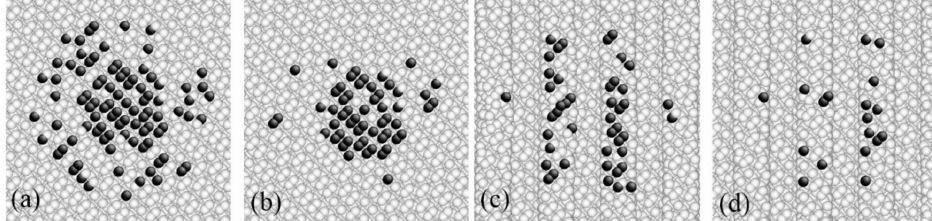
Figure 9. The real contact area of ( a ) the flat surface in adhesive contact, ( b ) the flat surface in nonadhesive contact, ( c ) the nanopatterned surface with l p = 2.17 nm and λ = 50% in adhesive contact, and ( d ) the same surface in nonadhesive